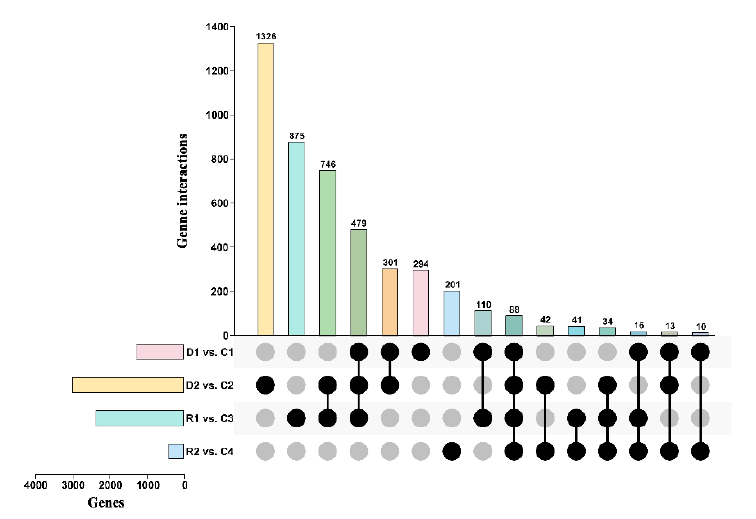
Figure 3. Global gene expression profiles and the identification of DEGs in response to the treatments. The Figure showing shared and unique DEGs of transcriptome associated with drought among drought and recovery stages. The overlap between the differentially expressed genes identified following the control, 8 days of drought, 23 days of drought, and 24 h of re-watering and 10 days of recovery.